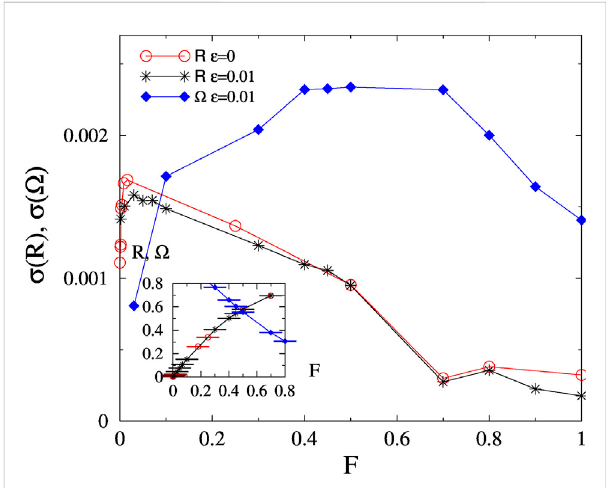
Fluctuationsof R and Ω as thefunctionof F for theKKI-18,for the noisy and the noiseless cases at K = 1. Inset: Order parameter R for the noisy and noiseless cases as well as Ω , denoted by the same symbols as in the main fi